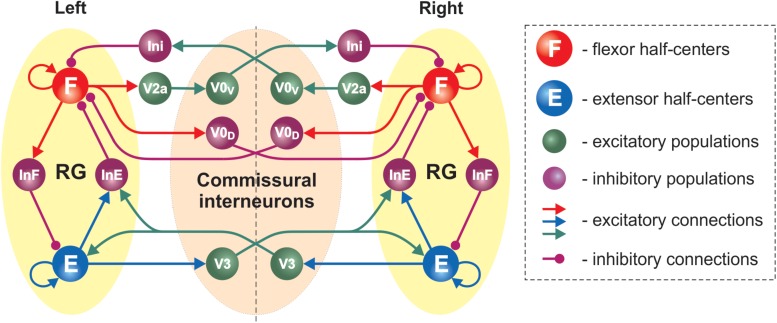
Model schematic of the bilateral spinal circuits consisting of two interconnected rhythm generators. Spheres represent neural populations and lines the synaptic connections between them. The rhythm generator (RG) in each side includes flexor and extensor centers (F and E, respectively) interacting via the inhibitory InF and InE populations. The left and right RGs interact via commissural interneurons (V0D, V0V, and V3).